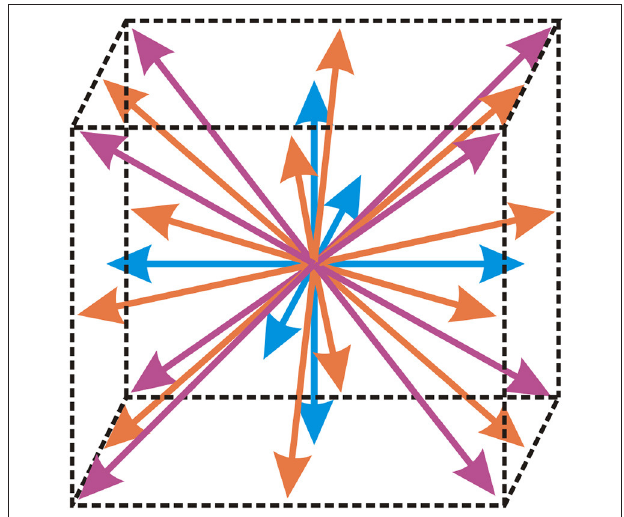
FIGURE 1 | Lattice structure D3Q27, that contains an overall of 27 different components of the distribution function. Arrows denote the possible directions of motion of fictional fluid